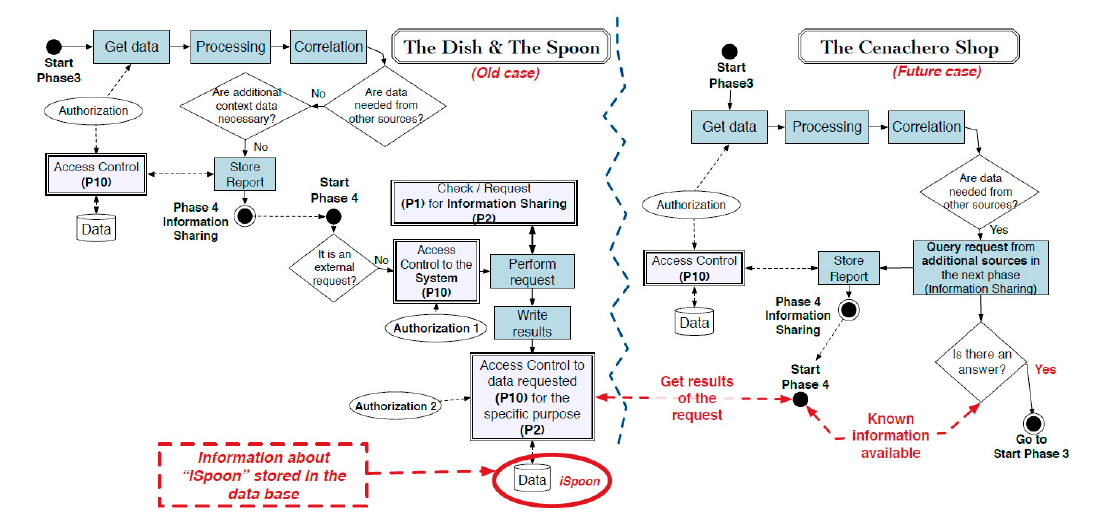
Figure 10. Correlation of information between two separate